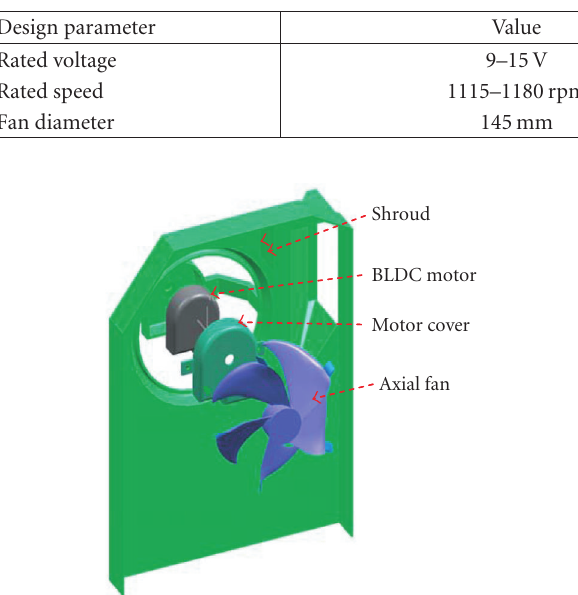
Table 1: Design parameters of the BLDC motor.